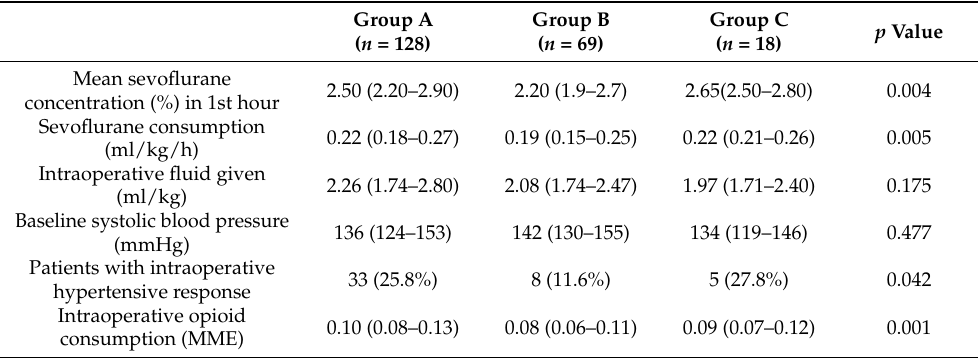
Table 2. Intraoperative presentations of patients who underwent knee arthroscopic surgery under bispectral index-guided sevoflurane anesthesia without adductor canal block (ACB) (Group A ), with preoperative ACB (Group B ), and with postoperative ACB (Group C ).